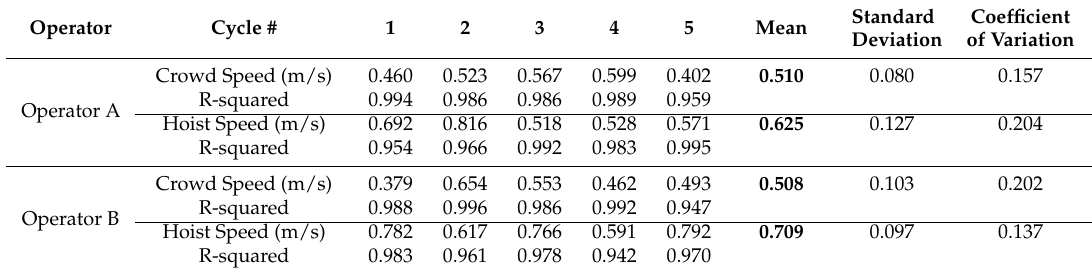
Table 3. Crowd and hoist speed